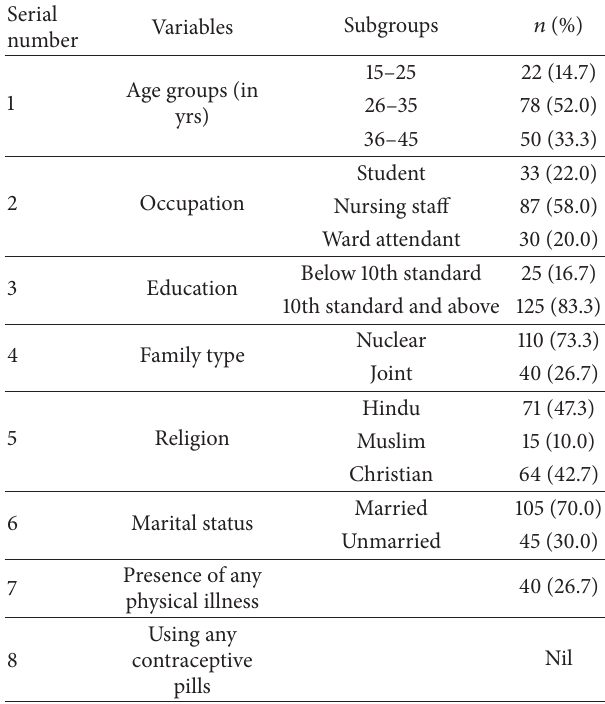
Table 1: Sociodemographic characteristics of the study sample ( 𝑁 = 150